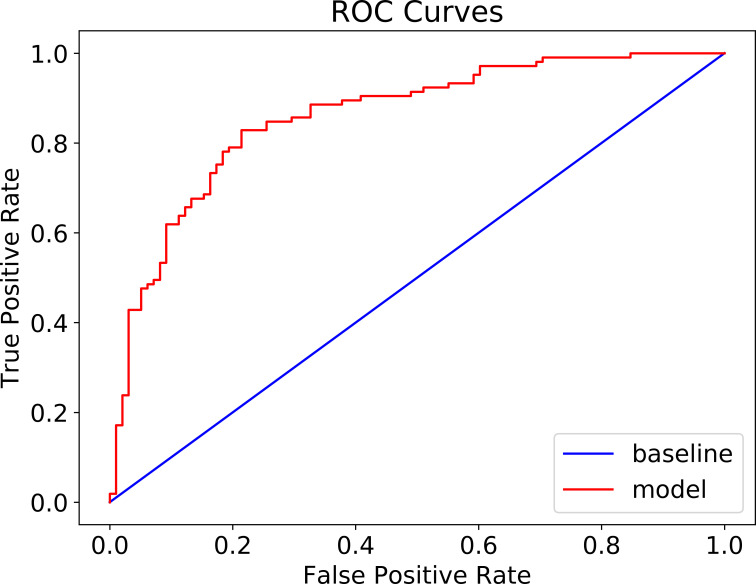
ROC of mortality prediction in balanced patient cohort (AUC: 86%).